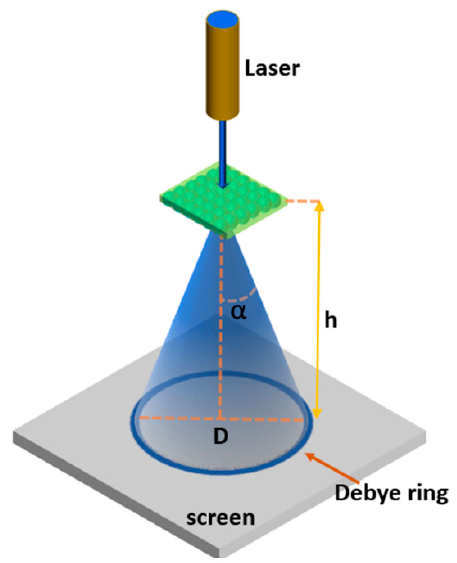
Figure 6. Schematic illustration of the Debye diffraction ring pattern produced by a 2D photonic crystal (PhC).